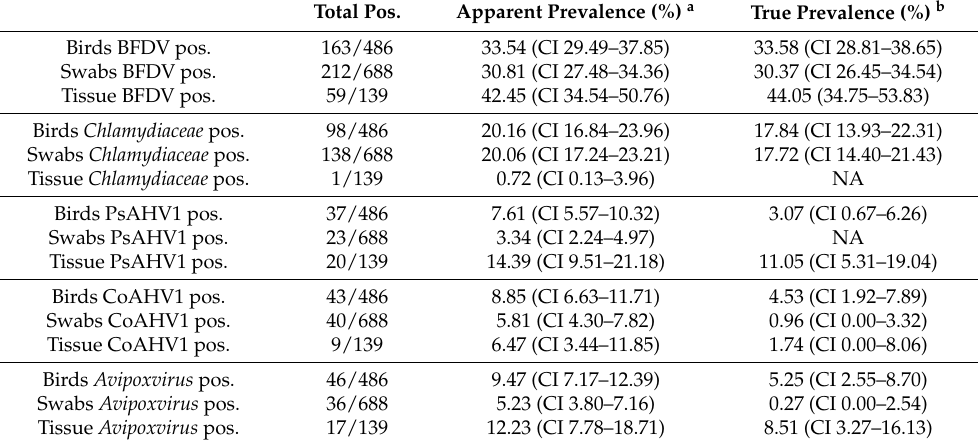
Table 1. qPCR detection rates of beak and feather disease virus (BFDV), Chlamydiaceae , psittacid alpha- herpesvirus 1 (PsAHV1), columbid alphaherpesvirus 1 (CoAHV1) and Avipoxvirus in birds and swab samples from this